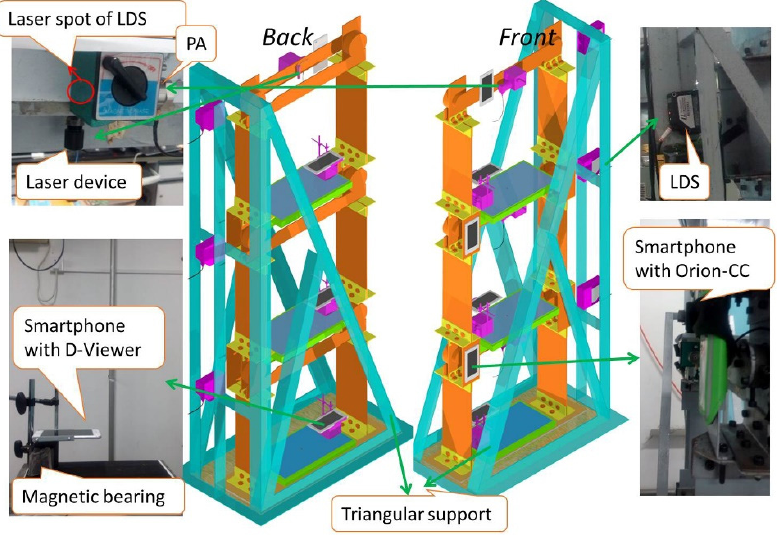
Figure 2. The various sensors instrumented in different locations in the steel frame testbed are shown.